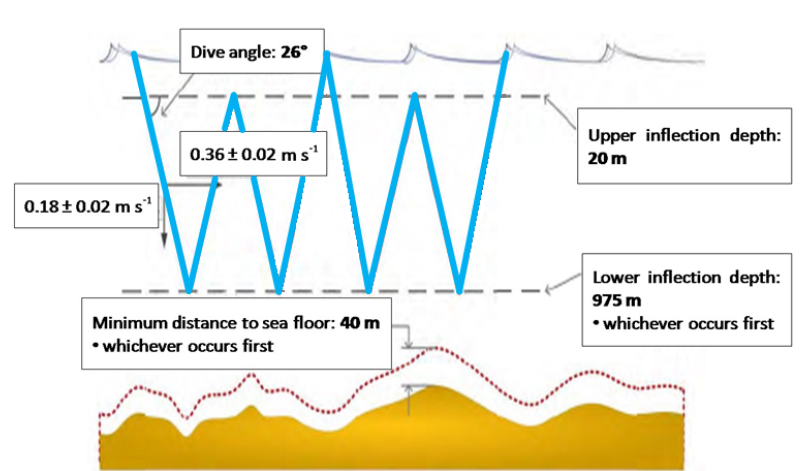
Figure 3. Glider navigation scheme during the ABACUS missions. The upper inflection depth was changed after the ABACUS 1 mission in order to allow the glider to reach the surface more